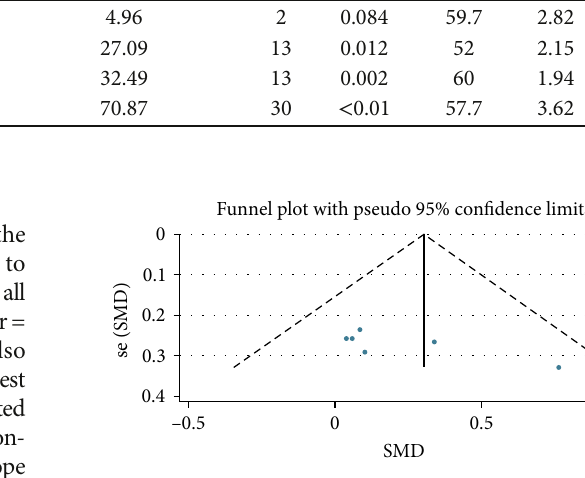
F IGURE 8: Funnel plots of publication bias